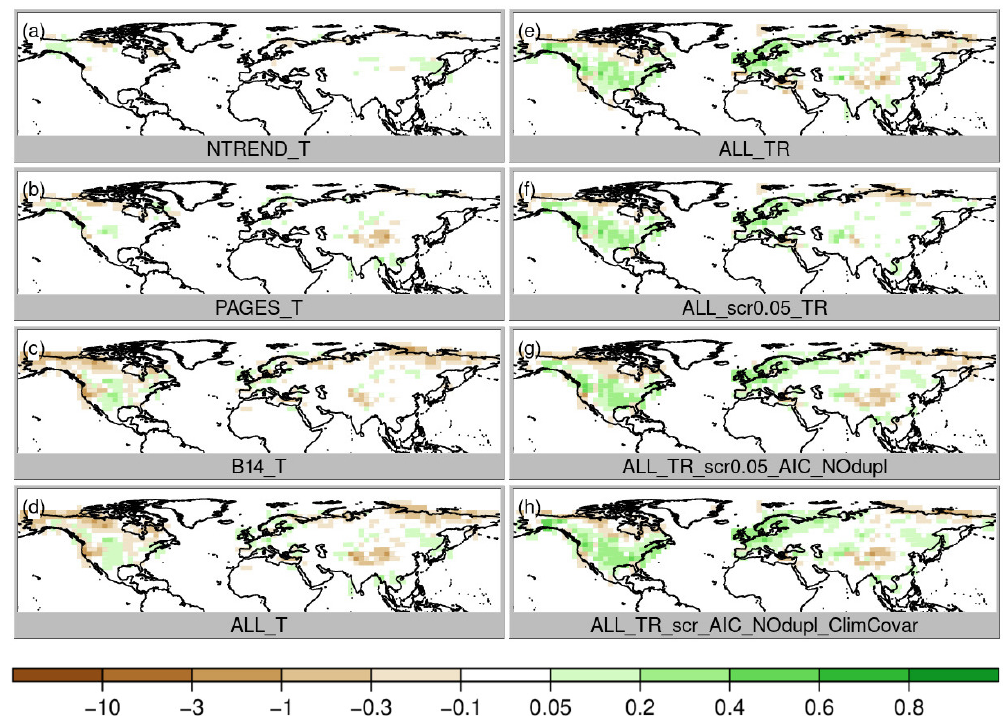
Figure 7. Precipitation RMSESS skill score, where greens colors indicate an improvement of the